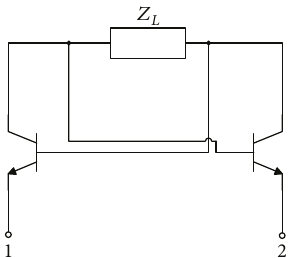
Figure 1: Schematic of the fl oating NIC without DC bias network.